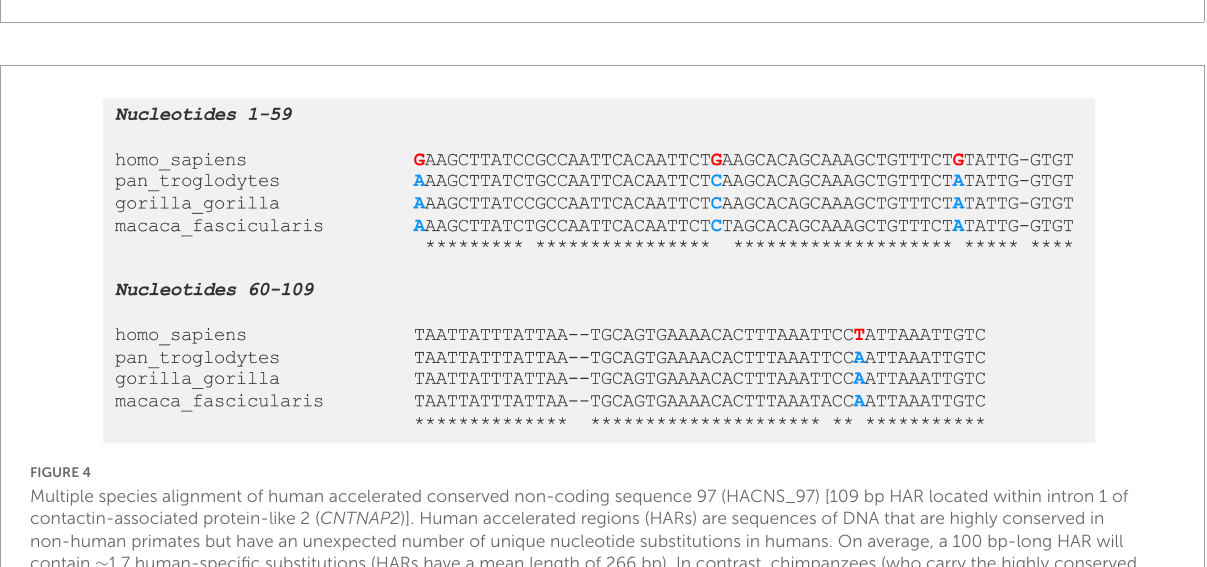
FIGURE4 Multiple species alignment of human accelerated conserved non-coding sequence 97 (HACNS_97) [109 bp HAR located within intron 1 of contactin-associated protein-like 2 ( CNTNAP2 )]. Human accelerated regions (HARs) are sequences of DNA that are highly conserved in non-human primates but have an unexpected number of unique nucleotide substitutions in humans. On average, a 100 bp-long HAR will contain ∼ 1.7 human-specific substitutions (HARs have a mean length of 266 bp). In contrast, chimpanzees (who carry the highly conserved ortholog), will have ∼ 0.2 unique substitutions. Even if a HAR gains only a small number of human-specific changes, this rate is significantly higher than observed in other conserved elements. Moreover, the regions surrounding HARs are usually still conserved, suggesting HARs may be part of a larger functional structure. Human Accelerated Conserved Non-coding Sequence 97 (HACNS_97) is shown as an example. HACNS_97 contains four nucleotides that are fixed in all humans but are absent in other primates (nucleotides highlighted in red and blue, respectively). Pan troglodytes = chimpanzee; Gorilla gorilla = western gorilla; Macaca fascicularis = crab-eating